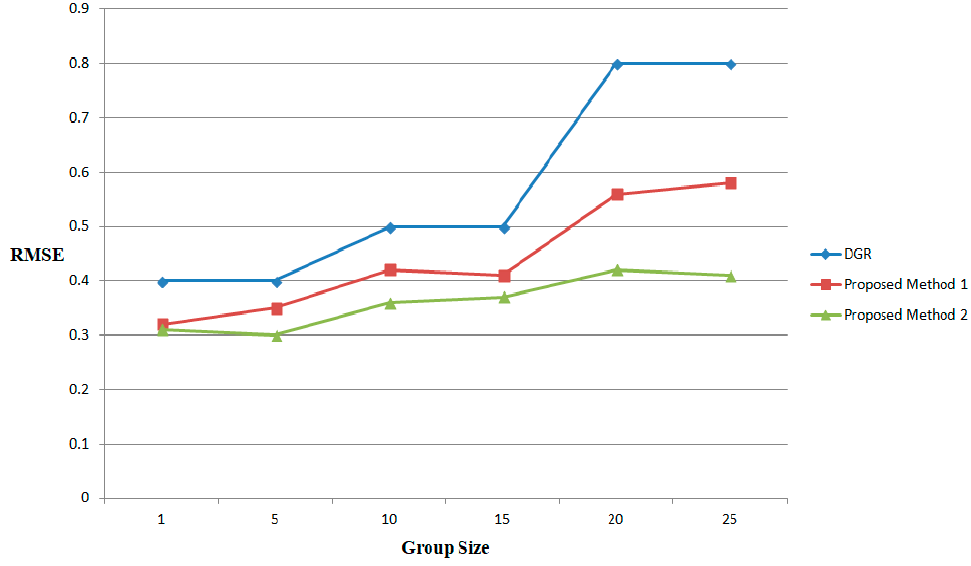
Figure 6. The RMSE Comparison of the Proposed Methods with DGR [50].